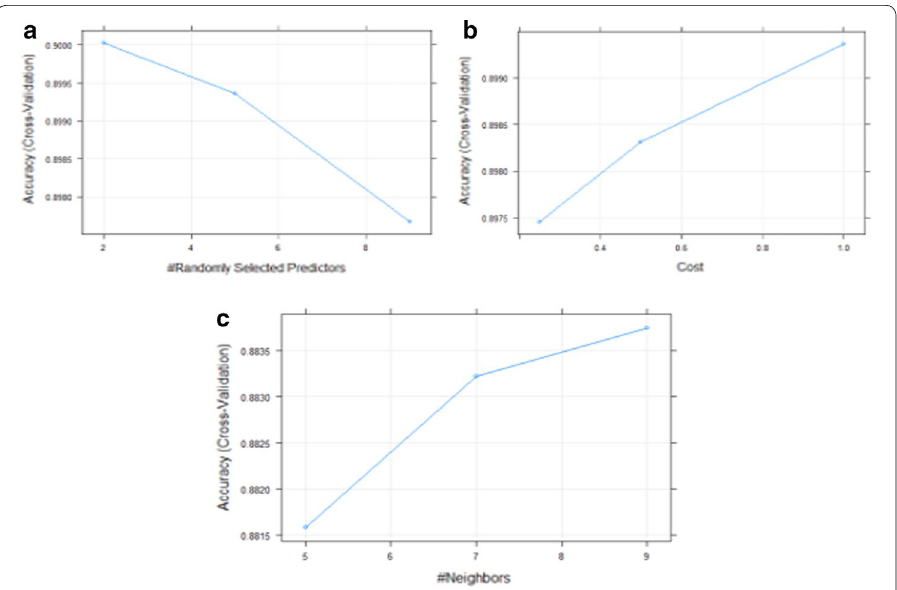
Fig. 5 Feature selection and classification method combination for Bank Marketing Dataset a RF RF SVM and c RF + +